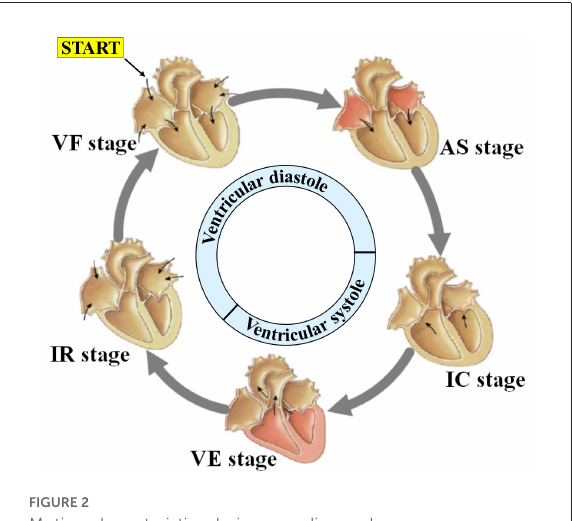
FIGURE2 Motion characteristics during a cardiac